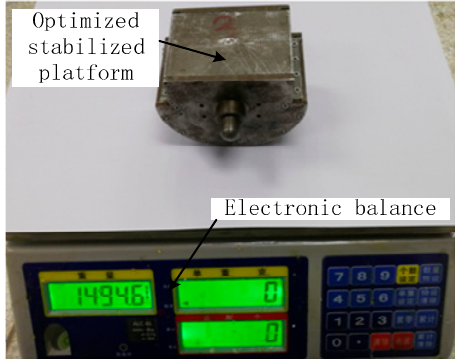
Figure 11. Quality of the SSP after optimization. Sensors 2018 , 18 , x FOR PEER REVIEW